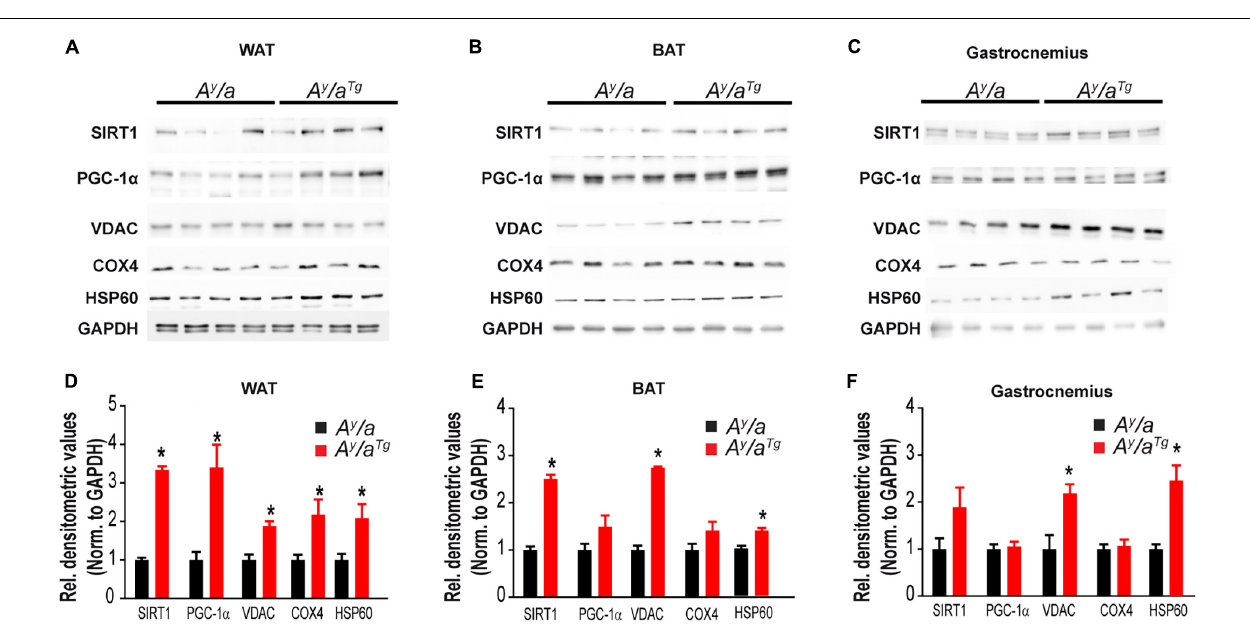
FIGURE 3 | Tissue mitochondrial content. Tissue expression of mitochondrial markers was measured by immunoblotting in (A,D) WAT, (B,E) BAT, and (C,F) Gastrocnemius. BAT, brown adipose tissue, COX4, cytochrome c oxidase; GAPDH, glyceraldehyde 3-phosphate dehydrogenase; HSP60, heat shock protein-60; PGC-1 α , peroxisome proliferator-activated receptor gamma coactivator 1-alpha; SIRT1, Sirtuin 1; VDAC, voltage-dependent anion channel; WAT, white adipose